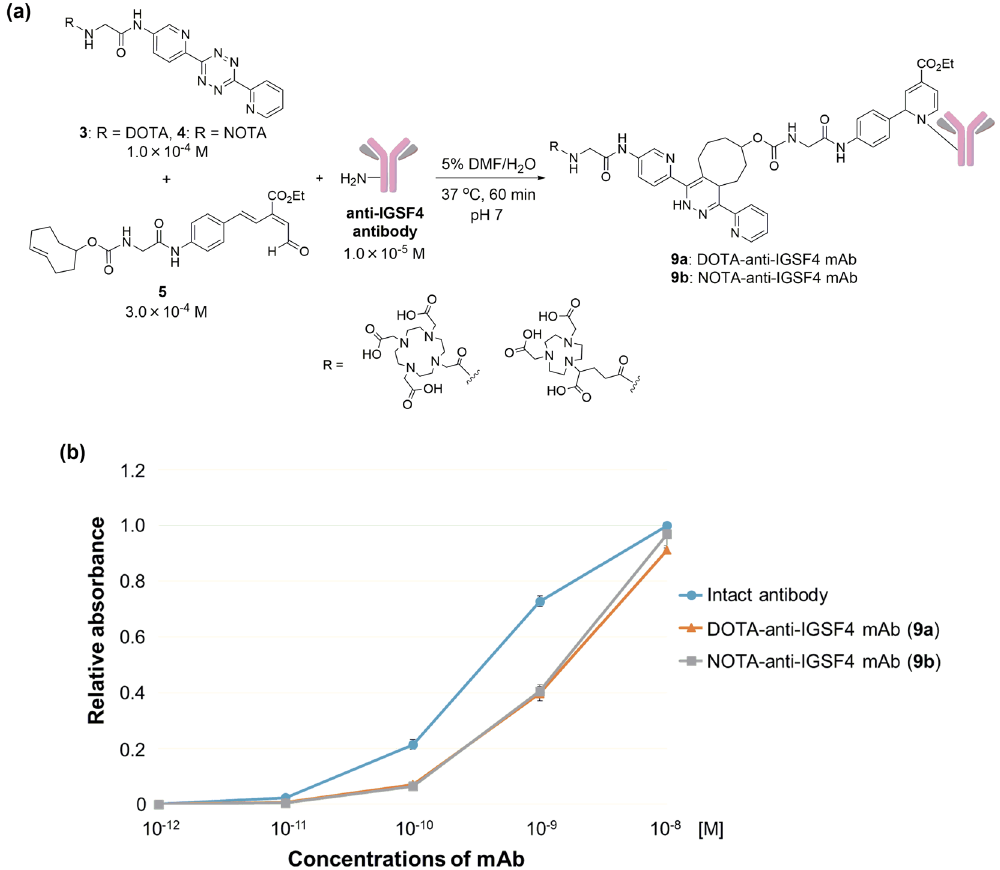
Figure 4. ( a ) One-pot three-component click labeling of anti-IGSF4 antibody as cancer-targeting agent. ( b ) Affinities of intact and labeled anti-IGSF4 antibodies to IGSF4 analyzed by ELISA. DMF = N , N -